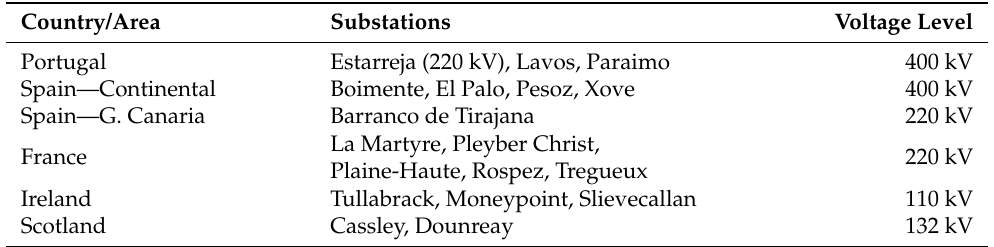
Table 4. Candidate nodes including substation name and voltage levels for all use